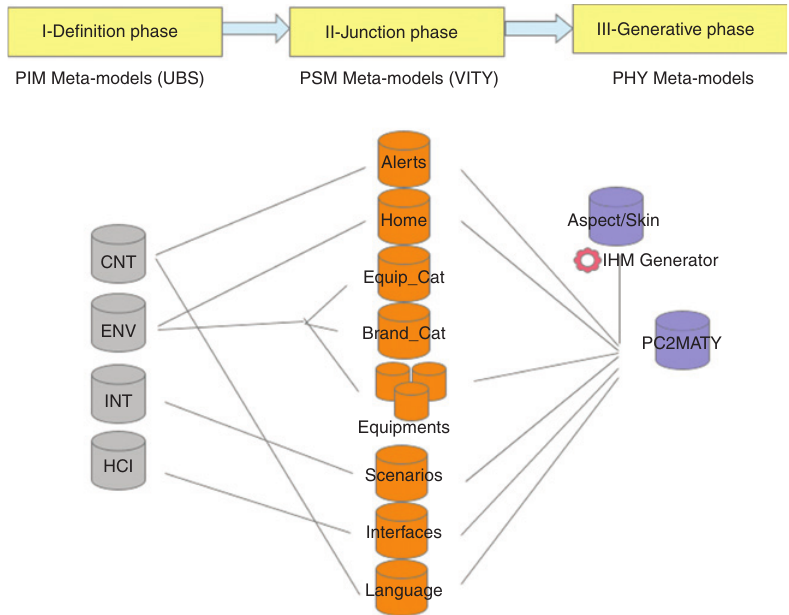
Figure 6: Meta-model Links in the Process Phases.